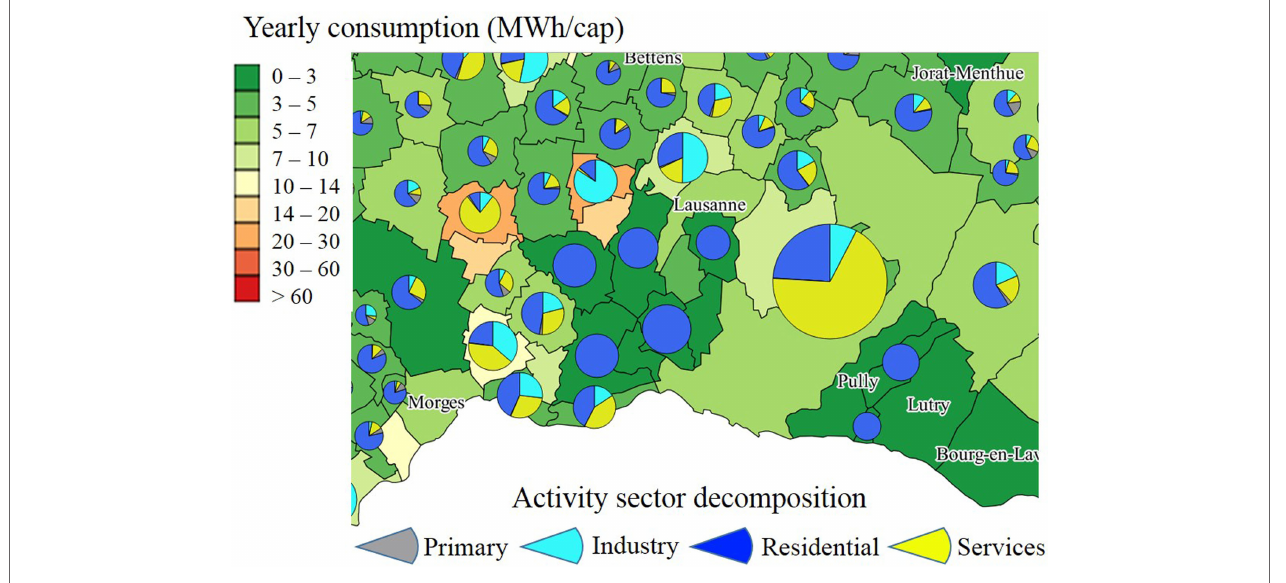
FIGURE 12 | Example of electricity consumption map in the surroundings of the city of